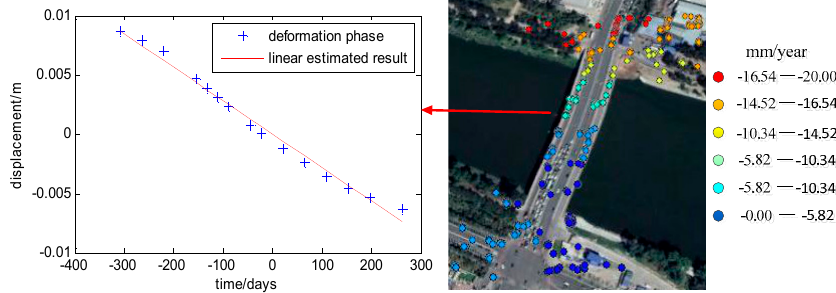
Figure 6. The linear deformation results of the Wenyuhe Bridge on Google Earth.